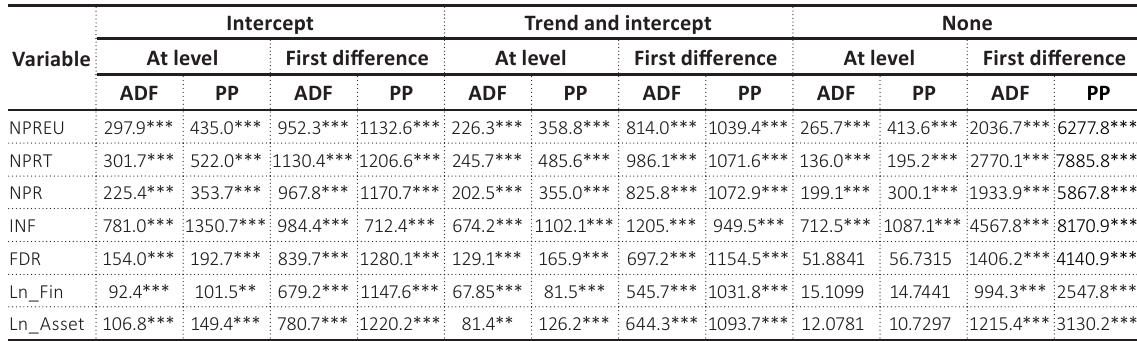
Table 1A. Panel unit root test